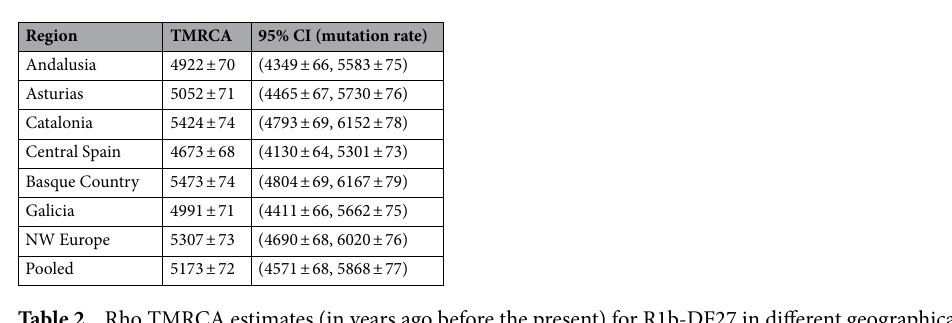
Table 2. Rho TMRCA estimates (in years ago before the present) for R1b-DF27 in different geographical regions. See Table S2 for the definition of each